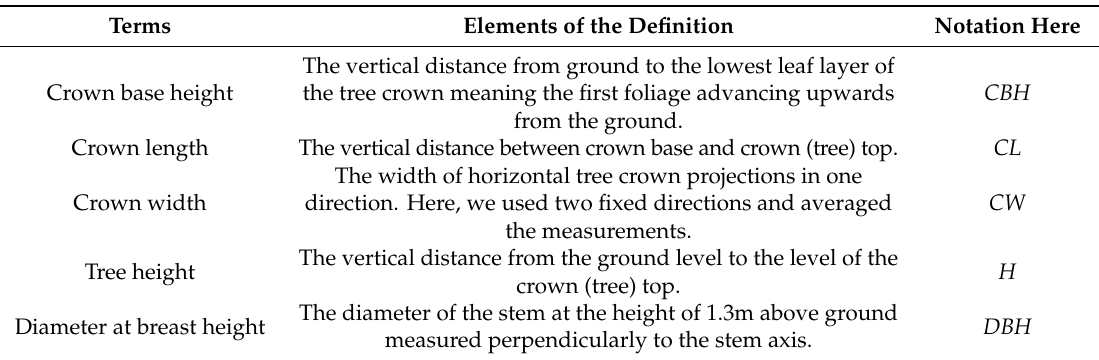
Table 1. Terms used in this study.